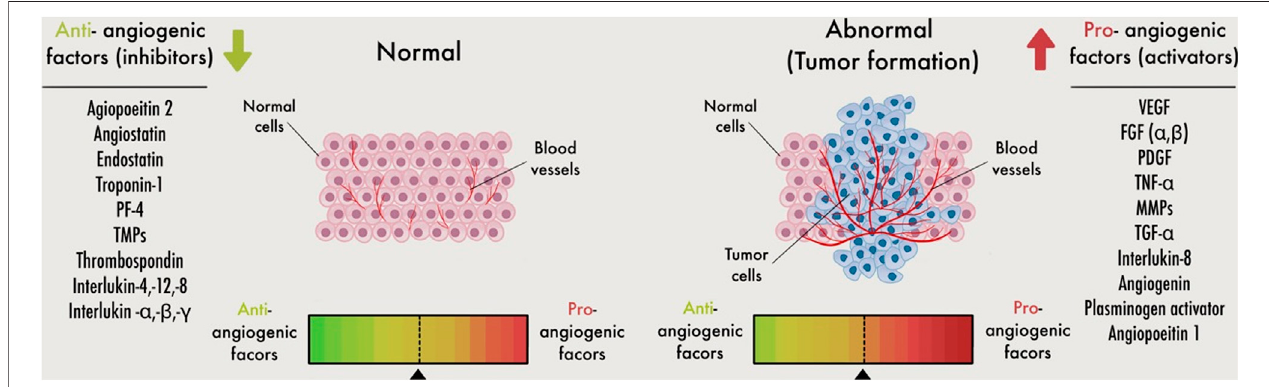
FIGURE4| Schematicimage for theangiogenicswitch.Angiogenesisiscontrolledbyacarefulbalance betweenpro-angiogenic and anti-angiogenic molecules in the bloodstream. Inadequate angiogenesis leads to a defect in the angiogenic balance, with a subsequent angiogenesis change toward excessive or reduced angiogenesis. Pro-angiogenic supports to stimulate the production of endothelial cells (ECs)during angiogenesis. Whereas anti-angiogenic factors, on the other hand, inhibit EC activation. More angiogenic than anti-angiogenic factors are involved when the angiogenic switch is